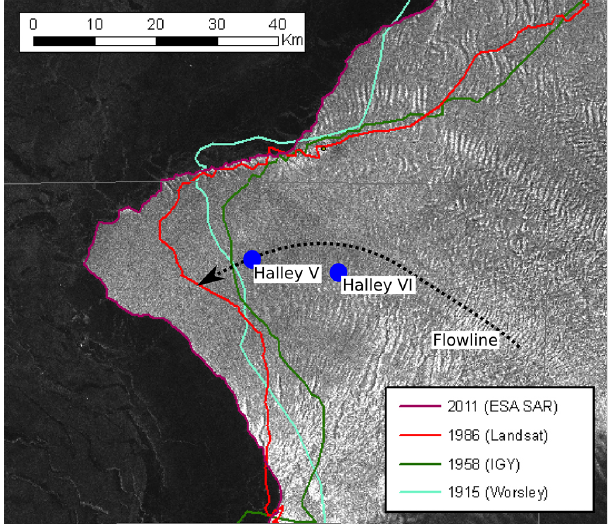
Fig. 4. A selection of historical ice fronts on the Brunt Ice Shelf (1915 position from Worsely, 1921). The unobserved period be- tween 1915 and 1958 can be expected to have a period of growth followed by a large calving